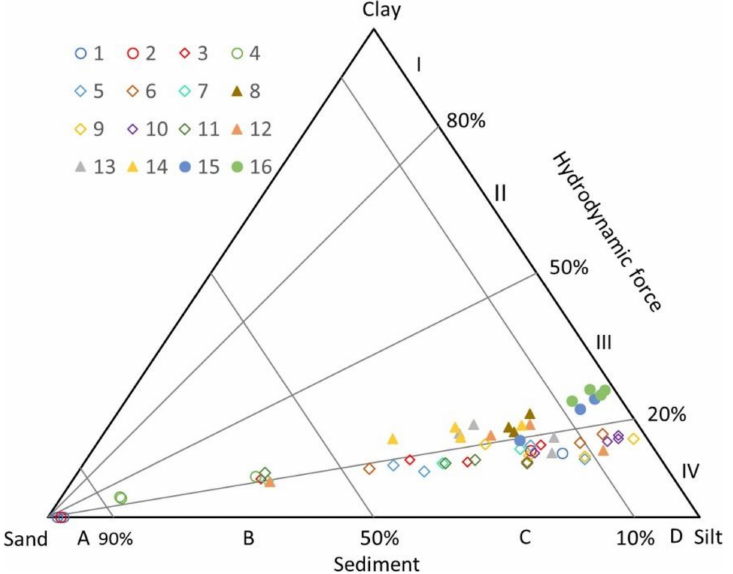
Figure 5. The Morten Pejrup triangle of the samples (the symbol bank, the symbol ♦ is used for the points beside the main stream, the symbol (cid:78) is used for the points on the middle-left bank, and the • symbol is used for the points on the inner-left